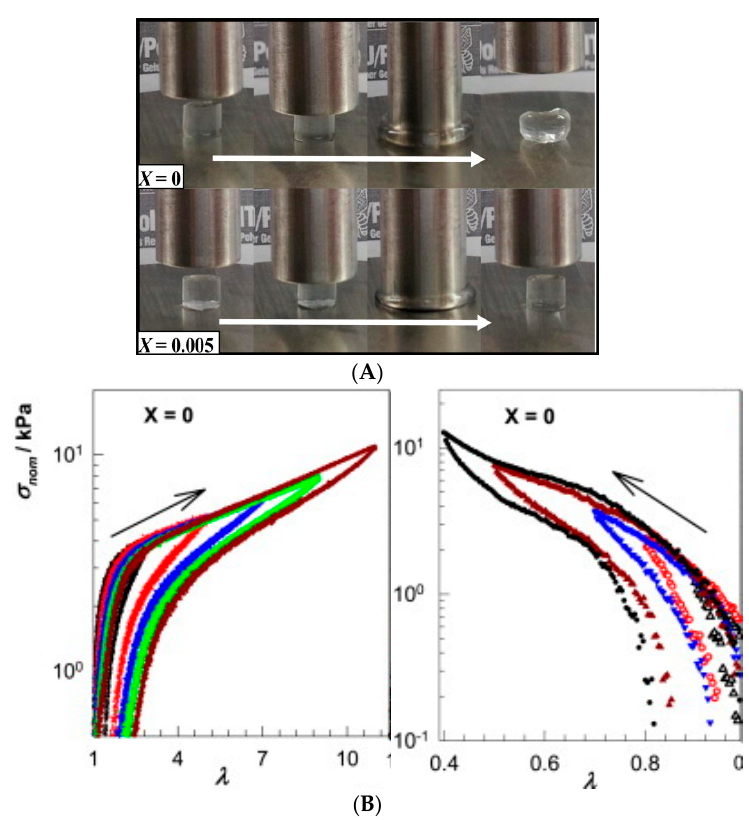
Figure 2. ( A ) Photographs of the physical (molar ratio of chemical crosslinker vs. monomer X = 0) and hybrid gels with combined chemical and physical crosslinking ( X = 0.005) during the compression tests. The physical gel remains deformed after removal of the stress ( top-right image); ( B ) Nominal stress σ nom vs. deformation ratio λ curves from cyclic elongation ( left ) and compression tests ( right ) for a physically crosslinked gel ( X = 0). Reprinted from [72] with permission, Copyright 2016 Elsevier.